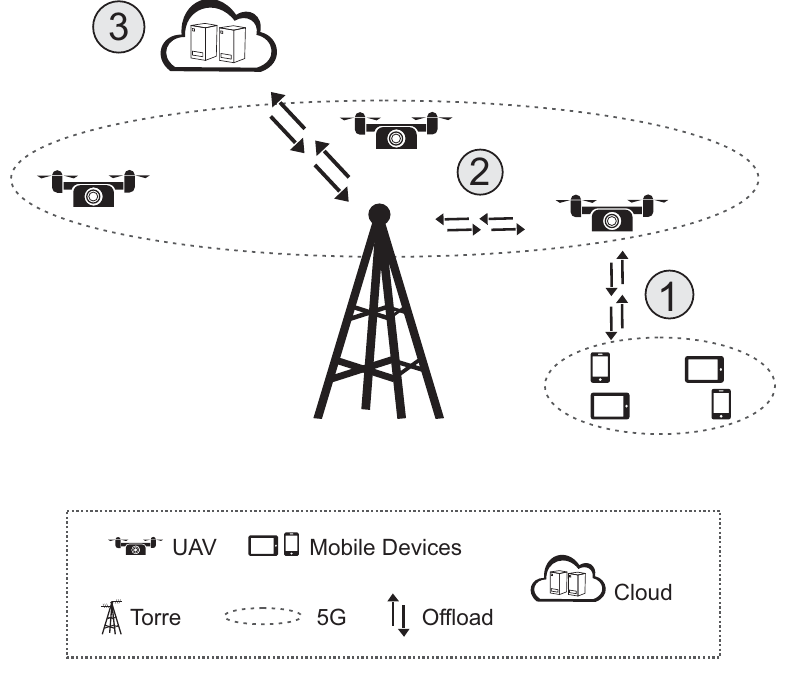
Figure 3. Base architecture composed of IoT devices, UAVs, base station and cloud